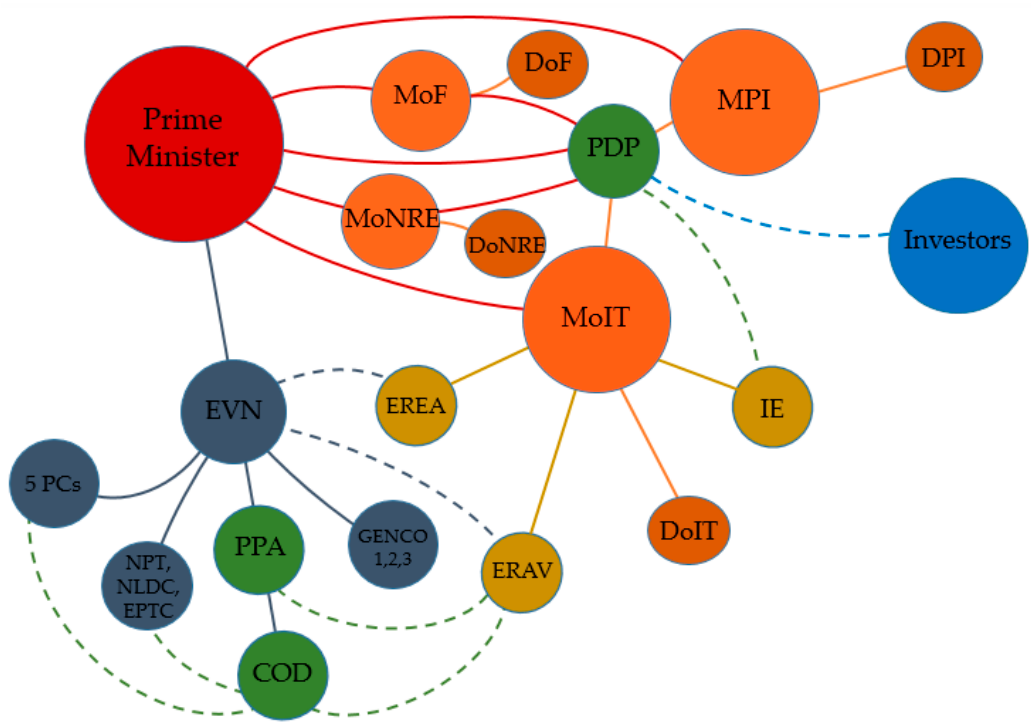
Figure 17. Actors in PDP, PPA, and COD of Vietnam solar power.